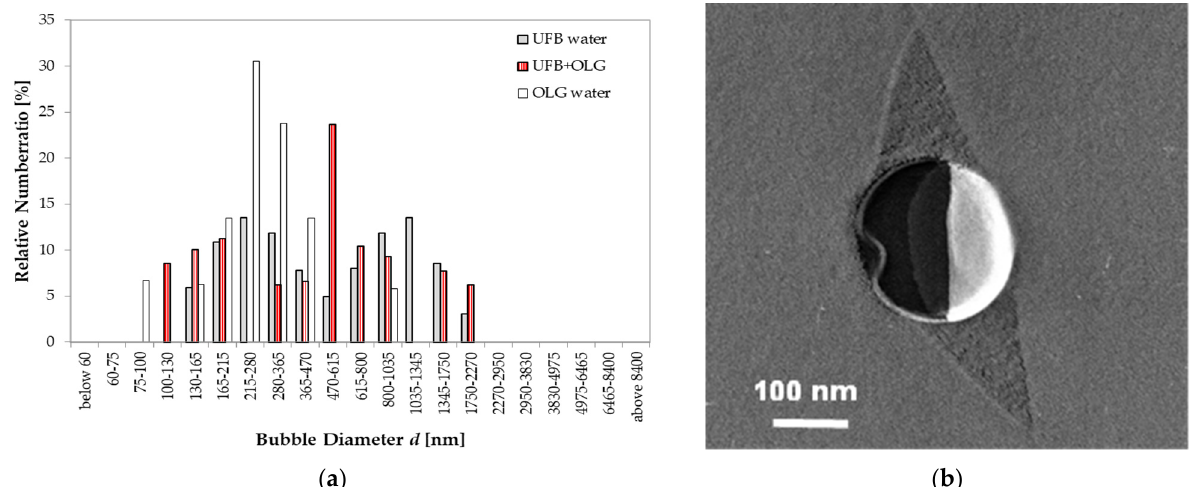
Figure 11. UFB sizes with OLG. ( a ) Size distributions in pure water (gray solid) and in water with OLG of 0.1 wt% (red hatched). Ordinate scale is the fraction of UFBs per listed size range (both distributions add up to 100%). Also shown in ( a ) are the particle sizes in 0.1 wt% OLG solution (open bar). ( b ) TEM image of freeze-fracture replica of a UFB in the OLG